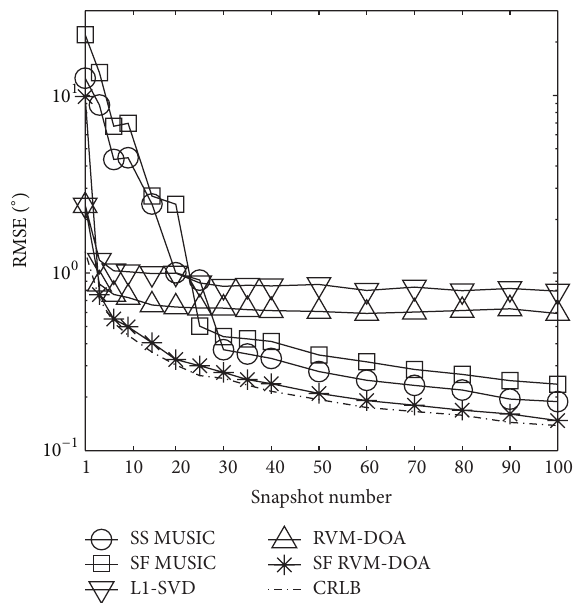
Figure 2: Averaged DOA estimation RMSE of two 7 dB coherent sources separated by 10 ∘ when the snapshot number